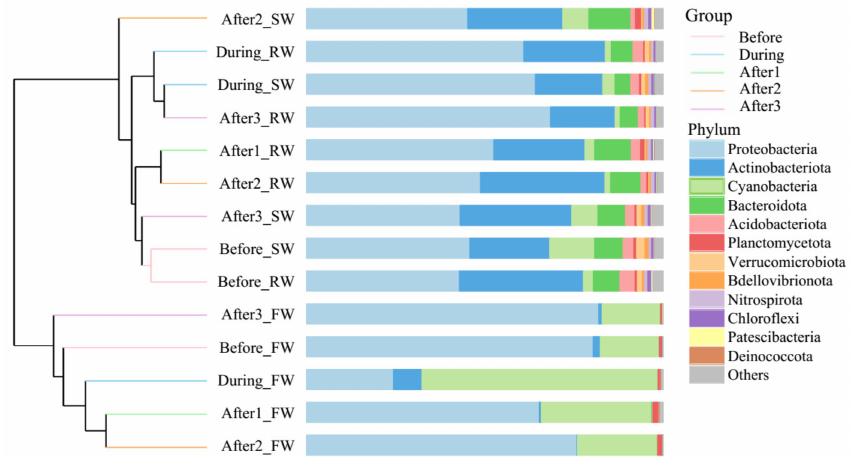
Figure 2. Bray–Curtis similarity-based dendrogram showing bacterial community composition in source water (SW), raw water (RW) and finished water (FW) during the five-day super typhoon period. The sampling dates are indicated by colored lines (before, during and after one, two and three days of the typhoon event). For each sample, community composition (phylum level) is indicated by bar